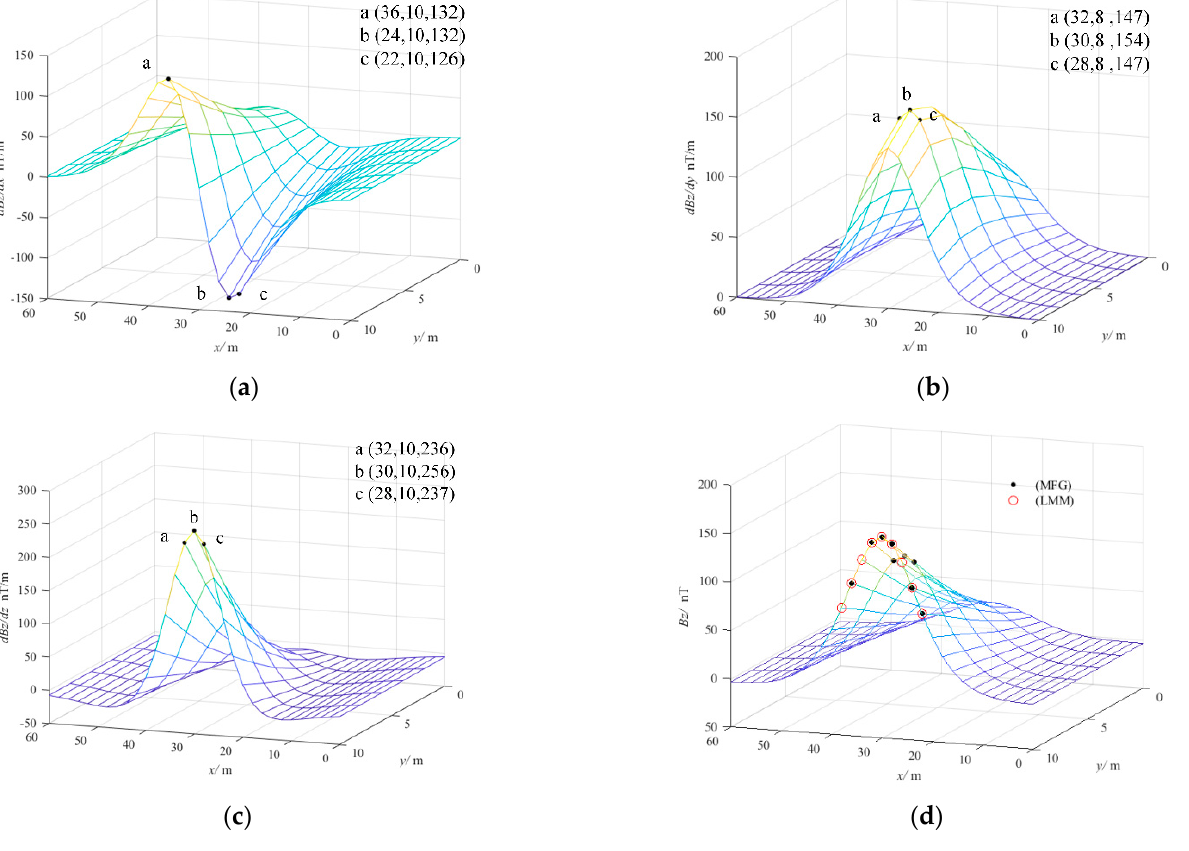
Figure 4. Positions of the magnetic source in the magnetic field and its gradients. ( a ) Positions of the magnetic source in x − direction gradient. ( b ) Positions of the magnetic source in y − direction gradient. ( c ) Positions of the magnetic source in z − direction gradient. ( d ) Positions of the magnetic source in the mag- netic field.